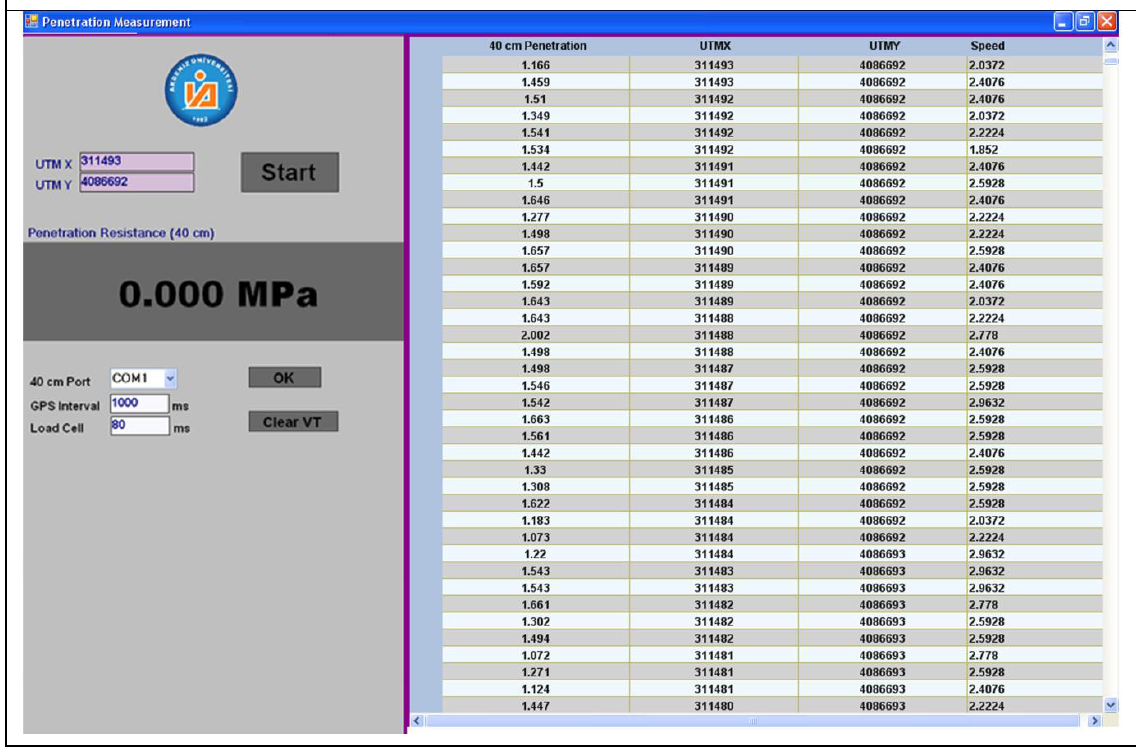
Figure 6. Developed software for penetration